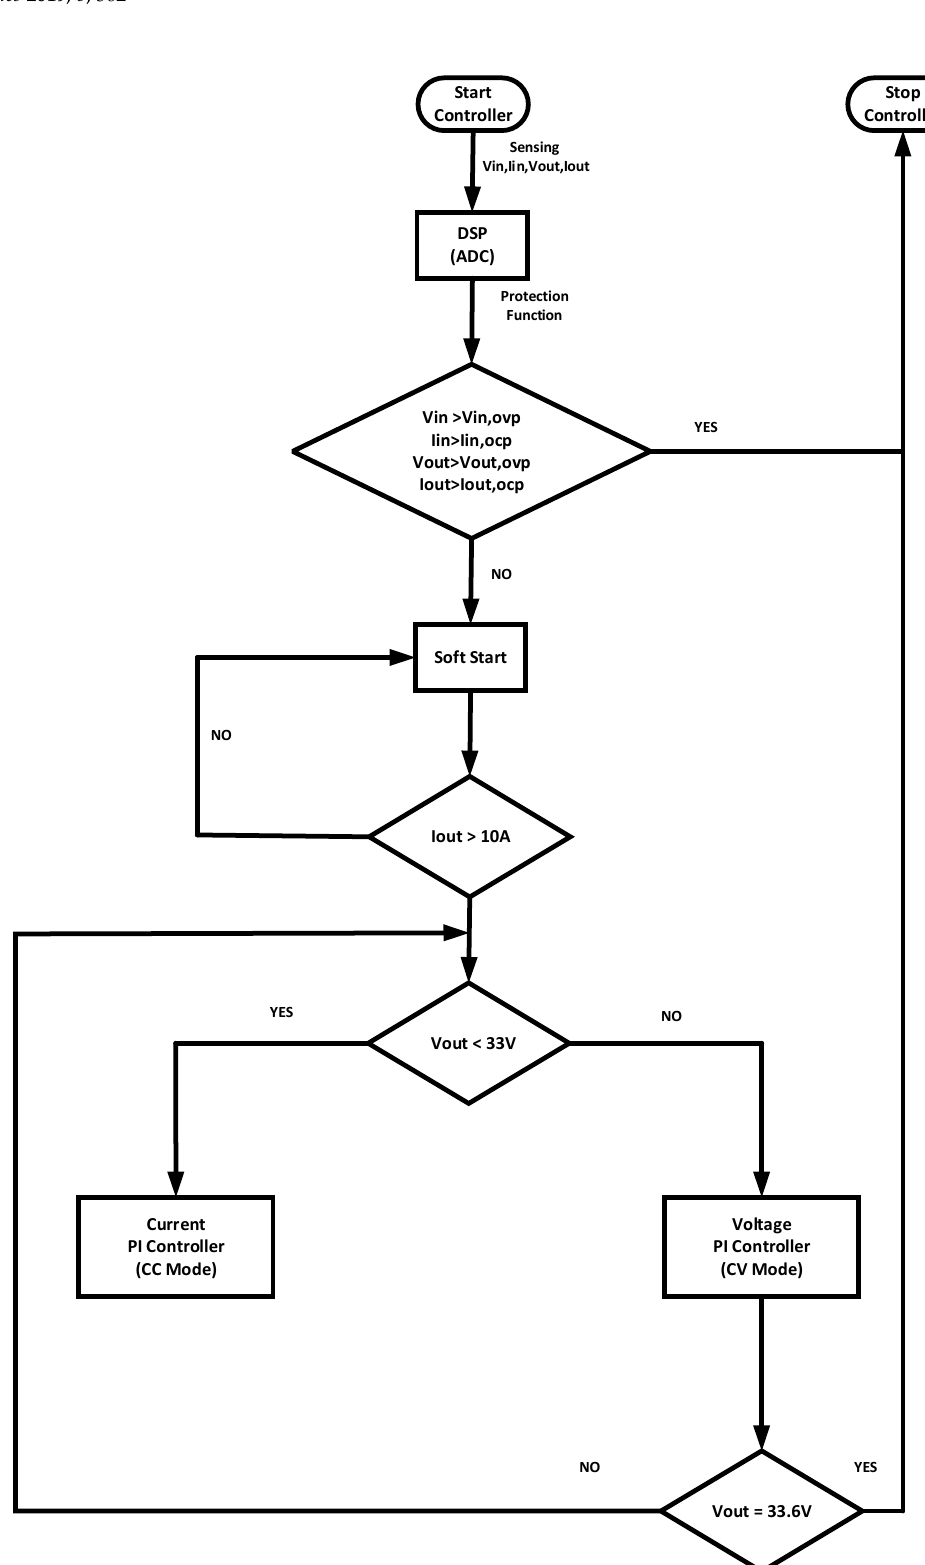
Figure 9. The proposed algorithm of LIB (Lithium-Ion Battery).